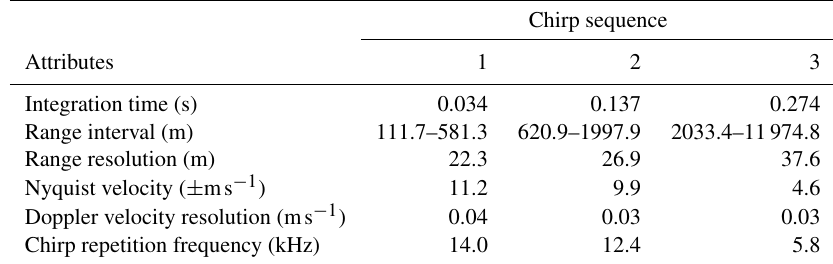
Table 2. Configuration parameters used by the single frequency radar MARA for each chirp